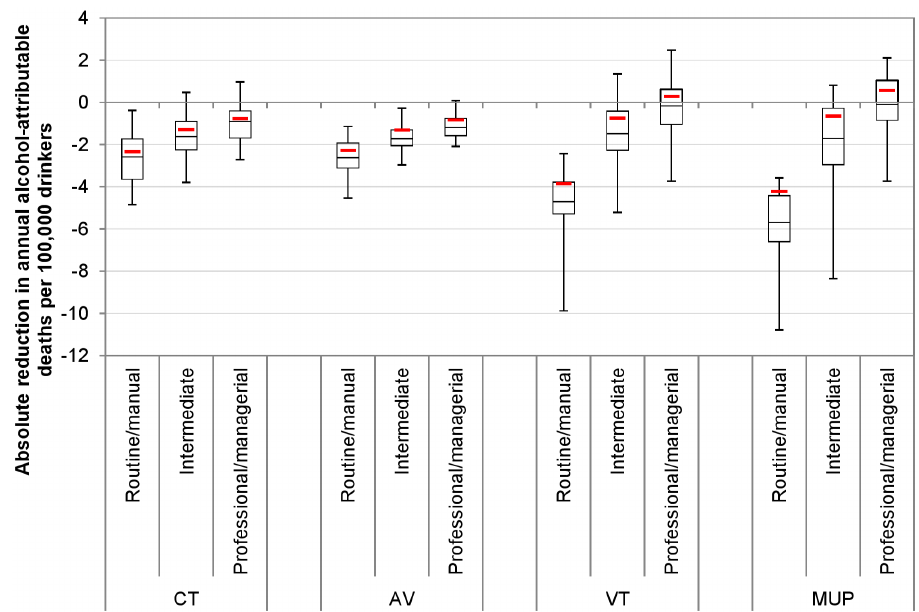
Fig 5. Probabilistic sensitivity analysis results for policy impacts on deaths by socioeconomic group. This figure shows the uncertainty in estimated policy impacts on death rates by socioeconomic group generated from 30 PSA runs. Whiskers represent maximum and minimum values. Boxes represent interquartile ranges. Mid-box lines represent medians. Red lines represent the baseline (deterministic) results. AV, ad valorem tax; CT, current tax increase; MUP, minimum unit pricing; VT, volumetric